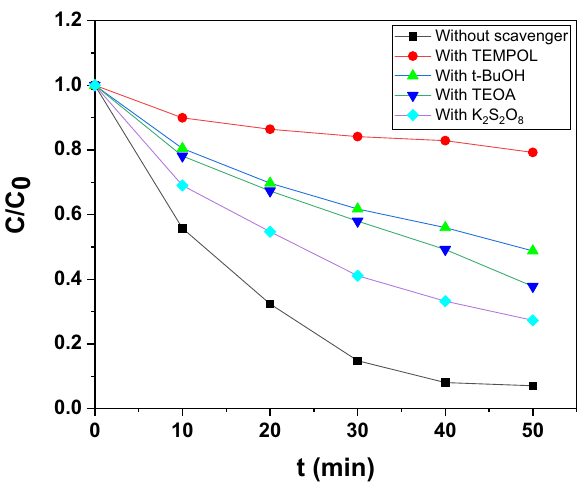
Figure 11. Effect of scavengers on photodegradation.